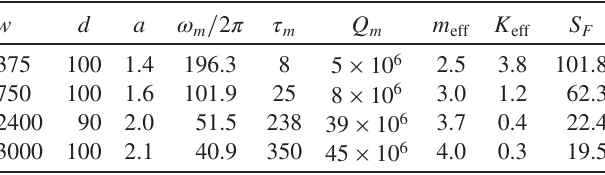
TABLE I. Frequency ω m = 2 π (kHz), ringdown time τ m (s), quality factor Q m , effective mass m (N/m), and force noise S F ð aN = Hz 1 = 2 Þ for the fundamental ( s 1 ) mechanical resonance of trampolines having varied window size